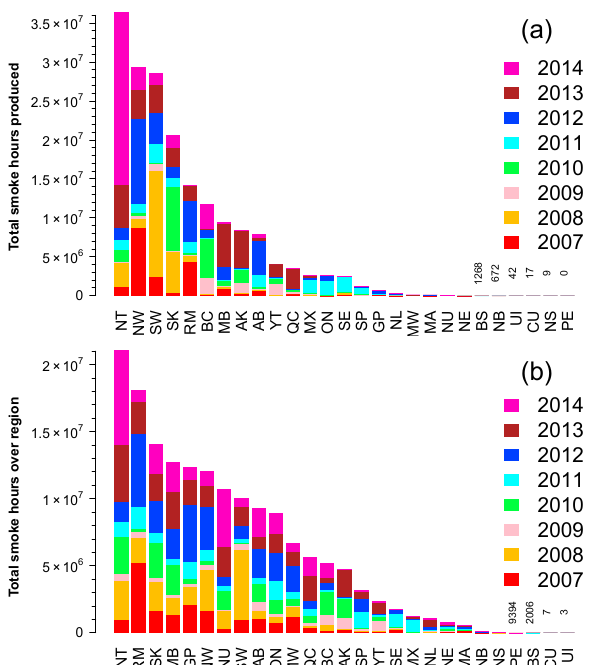
Figure 10. (a) Total number of smoke hours produced (anywhere) by each region for months June–September between 2007 and 2014 using GDAS1 meteorology. (b) Total number of smoke hours over each region for months June–September between 2007 and 2014 using GDAS1